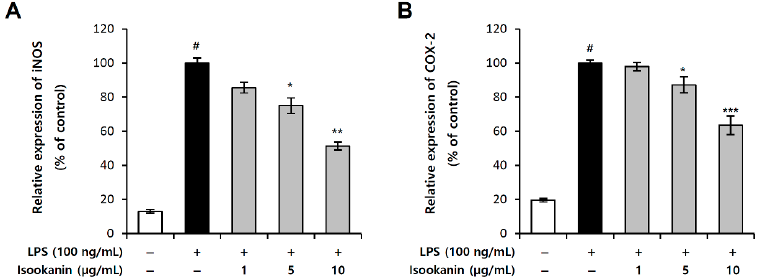
Figure 4. Effects of isookanin on inducible nitric oxide synthase (iNOS) and cyclooxygenase-2 (COX- 2) expression in LPS-induced RAW 264.7 cells. The ( A ) iNOS, and ( B ) COX-2 luciferase reporter vector was transfected into RAW 264.7 cells, and cultured for 24 h. The cells were pretreated with isookanin for 2 h, and then stimulated with LPS (200 ng/mL). Luciferase activity was calculated against an LPS-unstimulated control. The results are mean ± standard deviation (SD) ( n = 3). # p < 0.01 vs. LPS-untreated control. * p < 0.05, ** p < 0.01, and *** p < 0.001 vs. LPS-treated